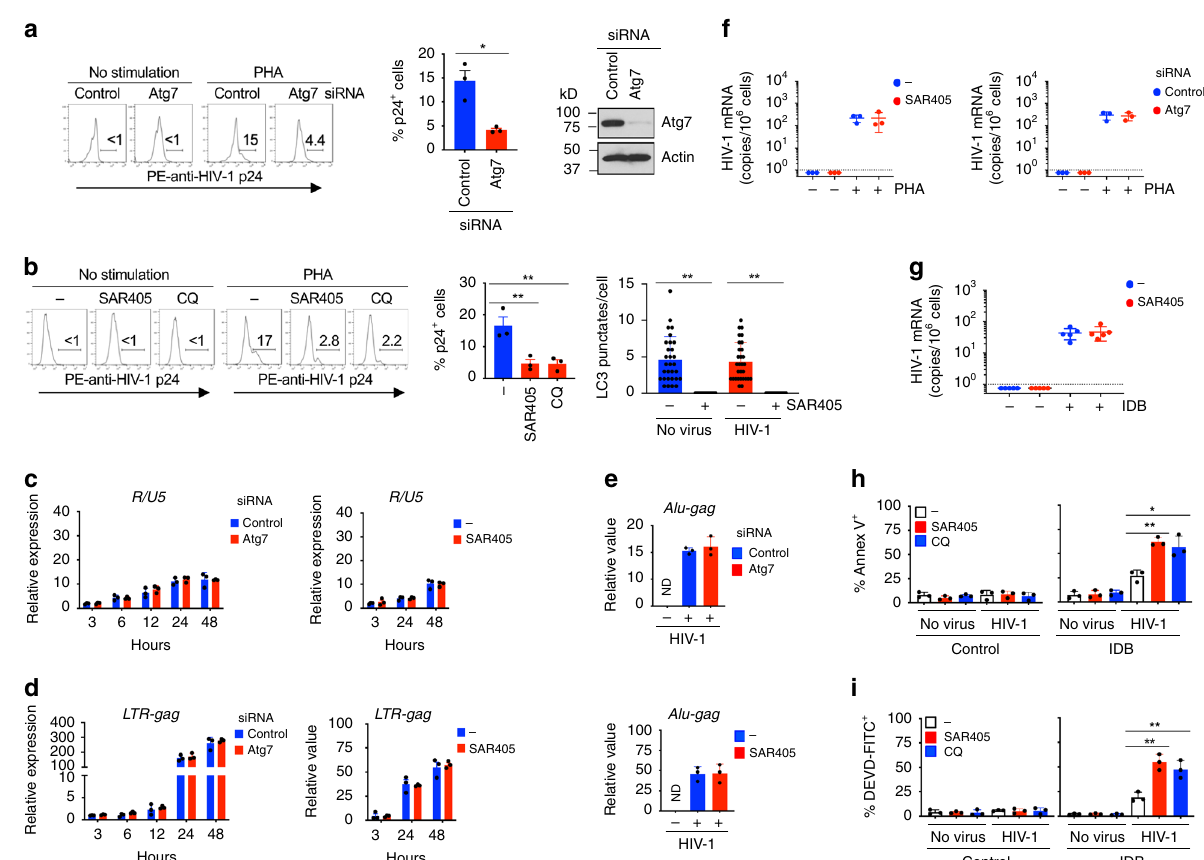
Fig. 1 Regulation of host cell survival, but not HIV-1 reverse transcription and integration into the host genome by inhibition of autophagy. a CMT transfected with Atg7 siRNA were infected with HIV-1 (NL4-3, 0.1 MOI) and cultured for 4 d to establish latency. After latency reversal by PHA, p24 + cells ( n = 3 biologically independent samples) and Atg7 expression (representative of two biologically independent experiments) were determined. * p = 0.011. b CMT latently infected with HIV-1 were stimulated with IDB with SAR405 (2 μ M ) or CQ (10 μ M ). p24 staining and the number of LC3 punctate per cells were analyzed. p24 + cells ( n = 3 biologically independent experiments), p = 0.010 (SAR405) and 0.0098 (CQ); LC3 punctate/cell ( n = 30 cells from two biologically independent experiments), p = 0.0001 (no virus) and 0.0001 (HIV-1). c , d Atg7 siRNA-transfected CMT were infected with HIV-1. Alternatively, CMT infected with HIV-1 were cultured with SAR405. Cells at different time after infection were collected ( n = 3 biologically independent samples) for RT-PCR for R/U5 c and LTR-gag d . e Alu-gag PCR for genomic DNA from CMT as in a , CMT treated with SAR405 as in b or uninfected CMT. Data were normalized against β -globin. ND: not detectable. Data are presented as mean ± SD ( n = 3 biologically independent samples). f , g CMT cultured as in a , b were reactivated with PHA for 24 h f ( n = 3 biologically independent samples). PBMCs from ART-treated HIV-1-infected patients ( n = 5 patients) were stimulated with IDB in the presence or absence of SAR405 for 24 h g . HIV-1 mRNA was determined by RT-PCR. Data are presented as mean ± SD. The dashed line indicates detection limit. h , i CMT latently infected with HIV-1 (NL4-3, 1 MOI) as in a were reactivated with 100 n M IDB for 24 h. Annexin V h or DEVD i staining were analyzed by fl ow cytometry ( n = 3 biologically independent samples). SAR405 vs. control, p = 0.0012 h , 0.0024 i ; CQ vs. control, p = 0.0164 h , 0.0088 i . Source data are provided as a Source Data fi